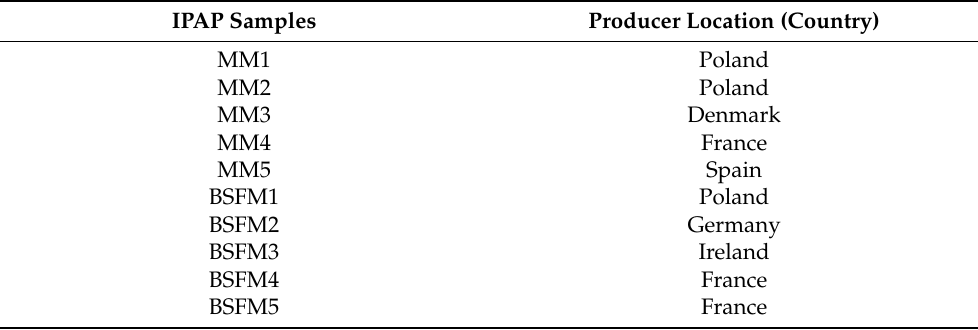
Table 2. Origin of IPAP used in the experiment. IPAP